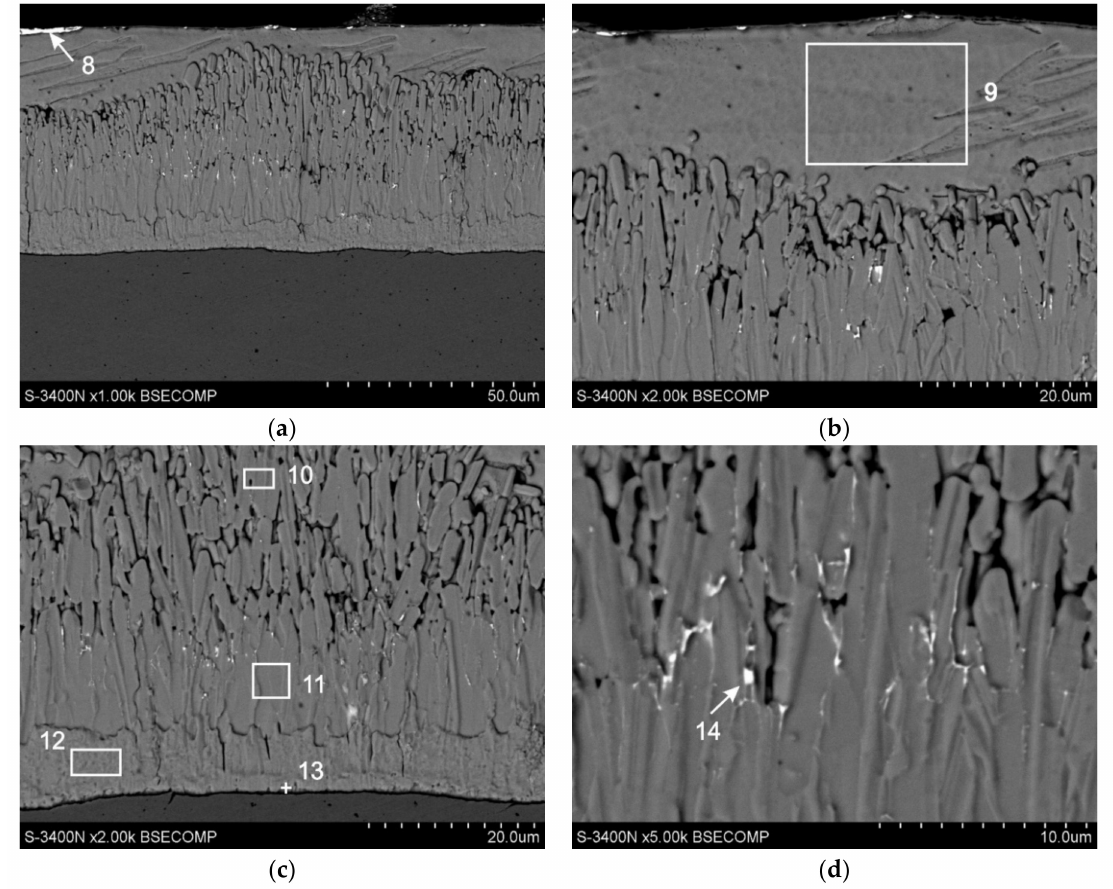
Figure 5. Cross-sectional microstructure (SEM) of the Zn-AlNiBiSn coating: ( a ) outlook of the coating cross-section, ( b ) top layer, ( c ) di ff usion layer, ( d ) inside of ζ